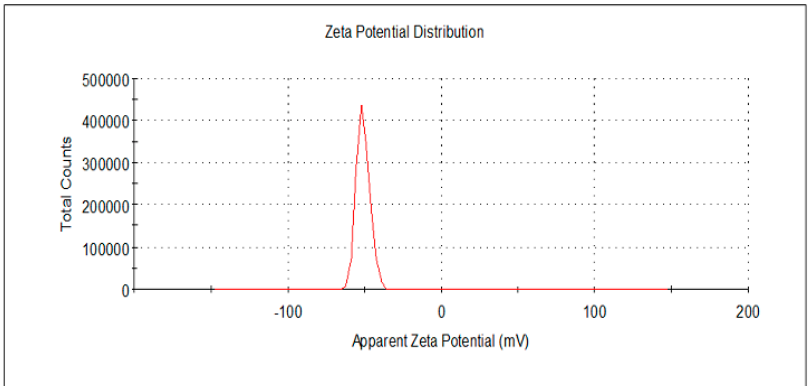
Figure 4. Zeta potential analysis of AuNPs prepared using 0.25 mM HAuCl 4 .